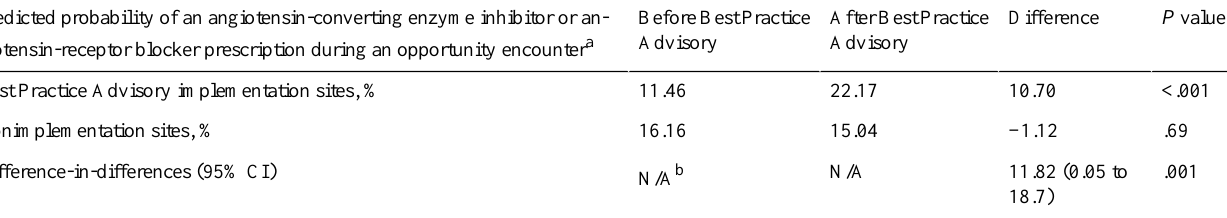
Table 4. Changes in angiotensin-converting enzyme inhibitor and angiotensin-receptor blocker prescriptions before vs after the implementation of Best Practice Advisory with a “chart closure” hard